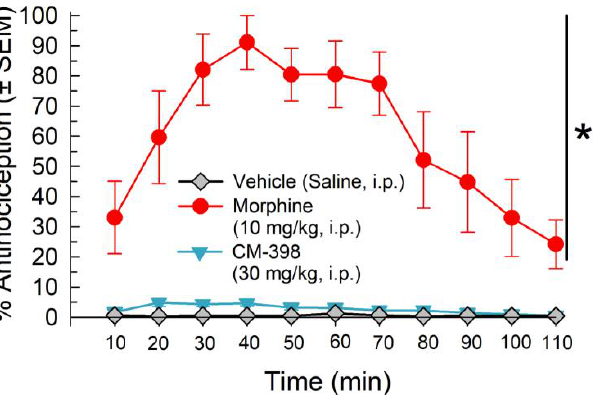
Figure 4. Evaluation of CM-398 for acute thermal antinociception in the 55 °C warm water tail-withdrawal assay. Mean ± SEM of latency to withdraw the tail from warm water after treatment with morphine (10 mg/kg, i.p.; red circles), CM-398 (30 mg/kg, i.p.; cyan triangles), or vehicle (0.9% saline, i.p.; gray diamonds) was examined every 10 min up to 110 min.; n = 7–8 for all points, * p < 0.05; two-way RM ANOVA with Tukey’s post hoc test.